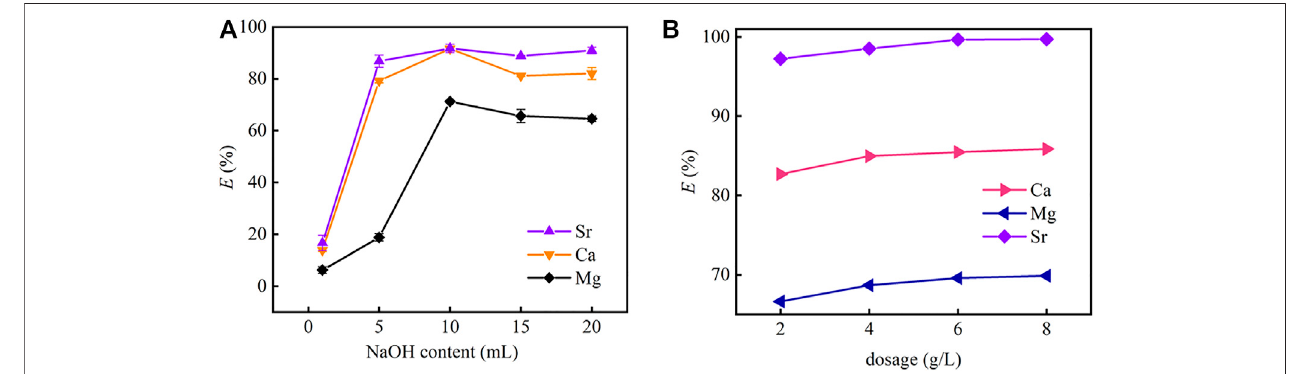
FIGURE 8 | (A) The effect of the concentration of NaOH on the precipitation of strontium by carbon dioxide nanobubbles with no adsorbent, (B) effect of PMBN3 adsorbent dosage on Sr(II) adsorption after precipitation (pH: 9, T : 298 K, t : 3 h, r : 120 rpm).